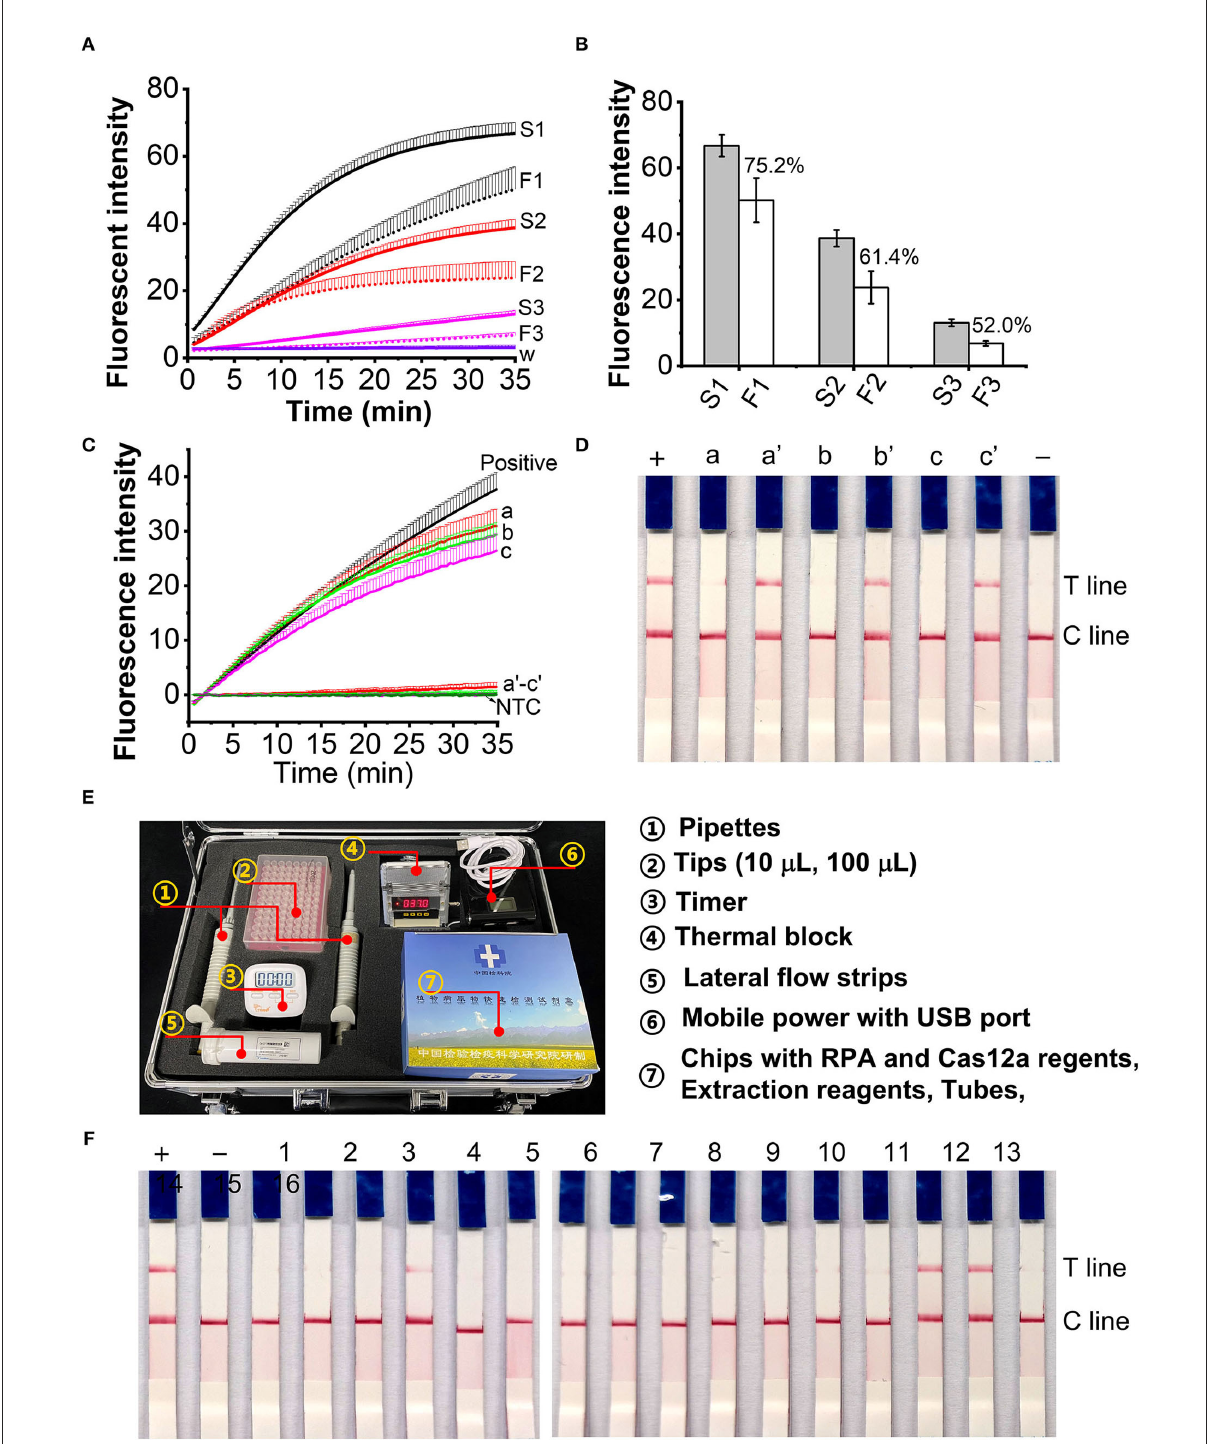
FIGURE6 Application of the RPA/Cas12a-based assay for field samples. (A) Fluorescent signals comparison of extracted DNA from 60 µ l (S1, F1), 40 µ l (S2, F2), and 20 µ l (S3, F3) using standard DNA extraction (S1, S2 and S3) and fast nucleic acid release reagents (F1, F2 and F3). (B) The ratio of fluorescence intensity (FI) at 30-min CRISPR reaction between S1-S3 and F1-F2, respectively. (C,D) Real time fluorescent signals (C) and lateral flow strips (D) of DNA extracted from plant tissues (a-c) and Lm hypha spiked plant tissues (a’-c’). a, a’: cabbage leaves; b, b’: oilseed rape stems; c, c’: oilseed rape seeds. (E) Picture of portable suitcase. (F) , The lateral flow assay results of unknown fungi samples. –, negative control; + , positive control. Sample 1-16 was identified with ITS1/ITS4 PCR amplification and Sequencing (Supplementary Table